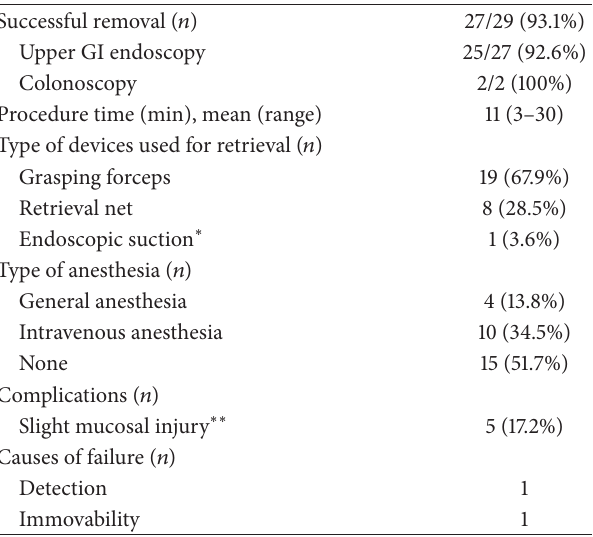
Table 3: Outcomes of the endoscopic removal procedure.